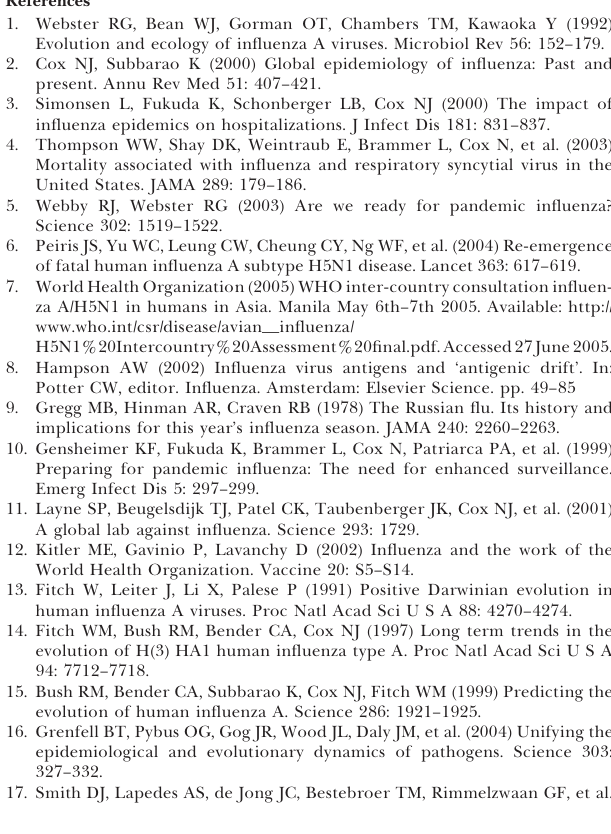
Table S1. Isolates of Influenza A Virus H3N2 Used in This Study Table S2. Parameter Values for Maximum Likelihood Phylogenetic Analysis Found at DOI: 10.1371/journal.pbio.0030300.sg001 (50 KB